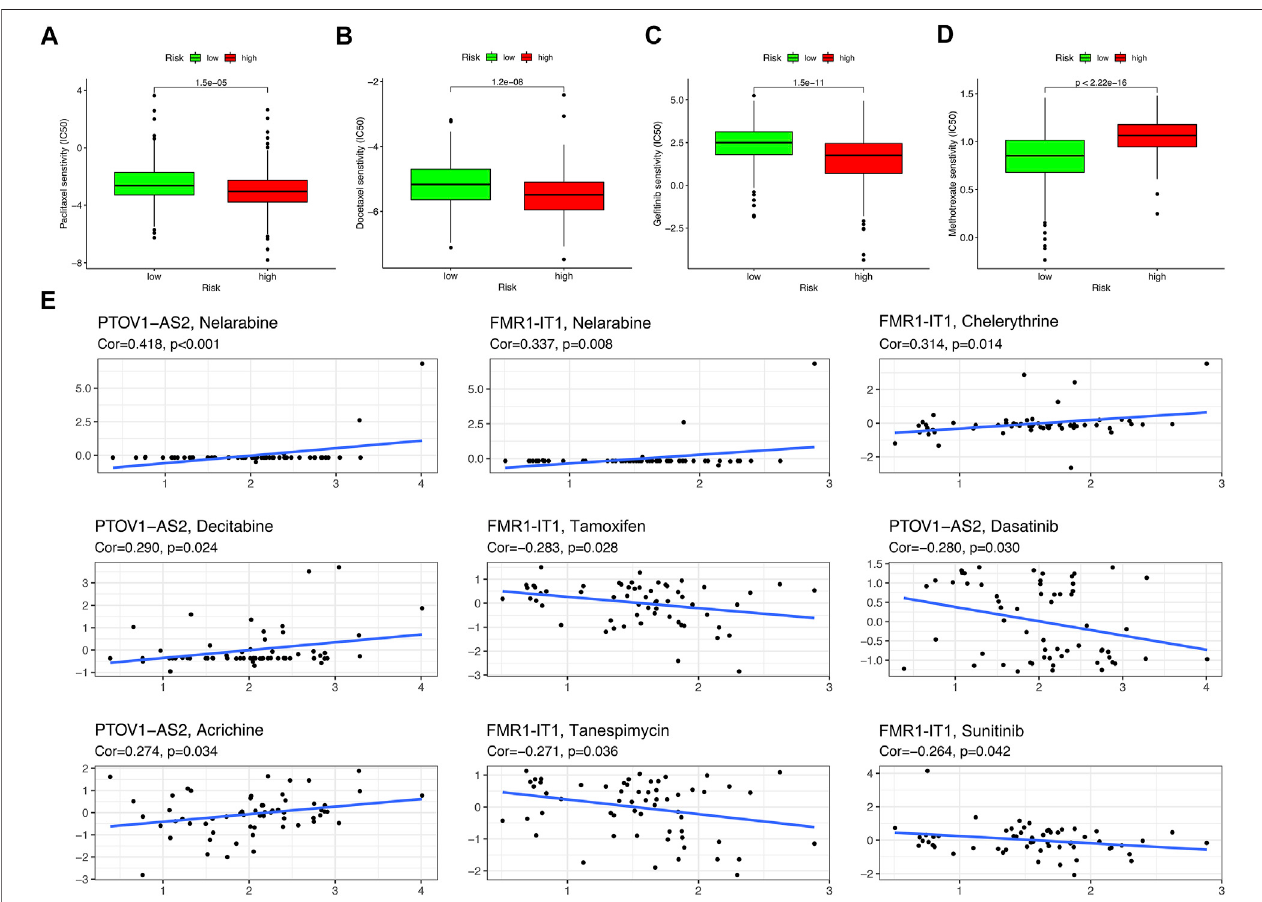
FIGURE10| Drugsensitivity analysis. (A – D) TheboxplotofSensitivityofPaclitaxel,Docetaxel,Ge fi tinib, Methotrexateinpatientswithhigh-risksubgroup andlow- risk subgroup. (E) The scatter plot showed the correlation between prognostic lncRNAs expression and drug sensitivity (Z score of CellMiner interface). Top 10 associations were displayed, sorted by p